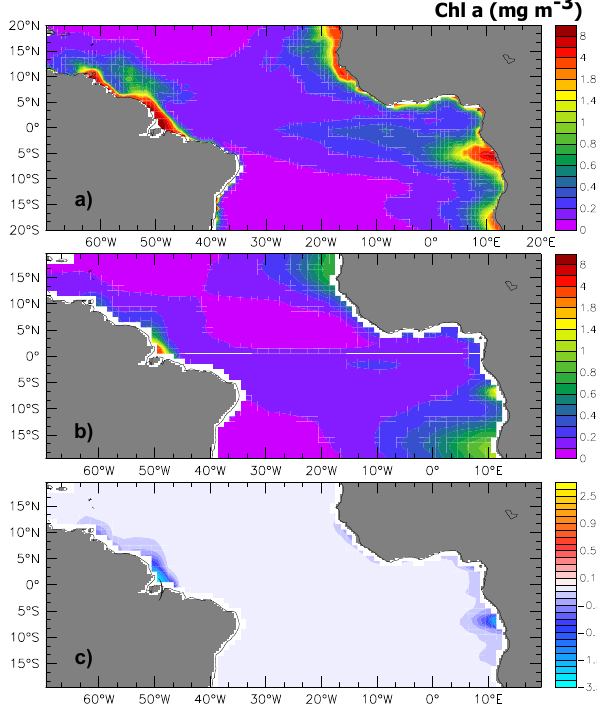
Fig. 3. Mean surface chlorophyll a (Chl a ) in mgChl a m − 3 (average 1998–2005) from (a) satellite SeaWiFS, (b) the TO- DAY standard scenario, and (c) difference in surface chlorophyll a (mgChl a m − 3 ) between the NO_RIVER and TODAY